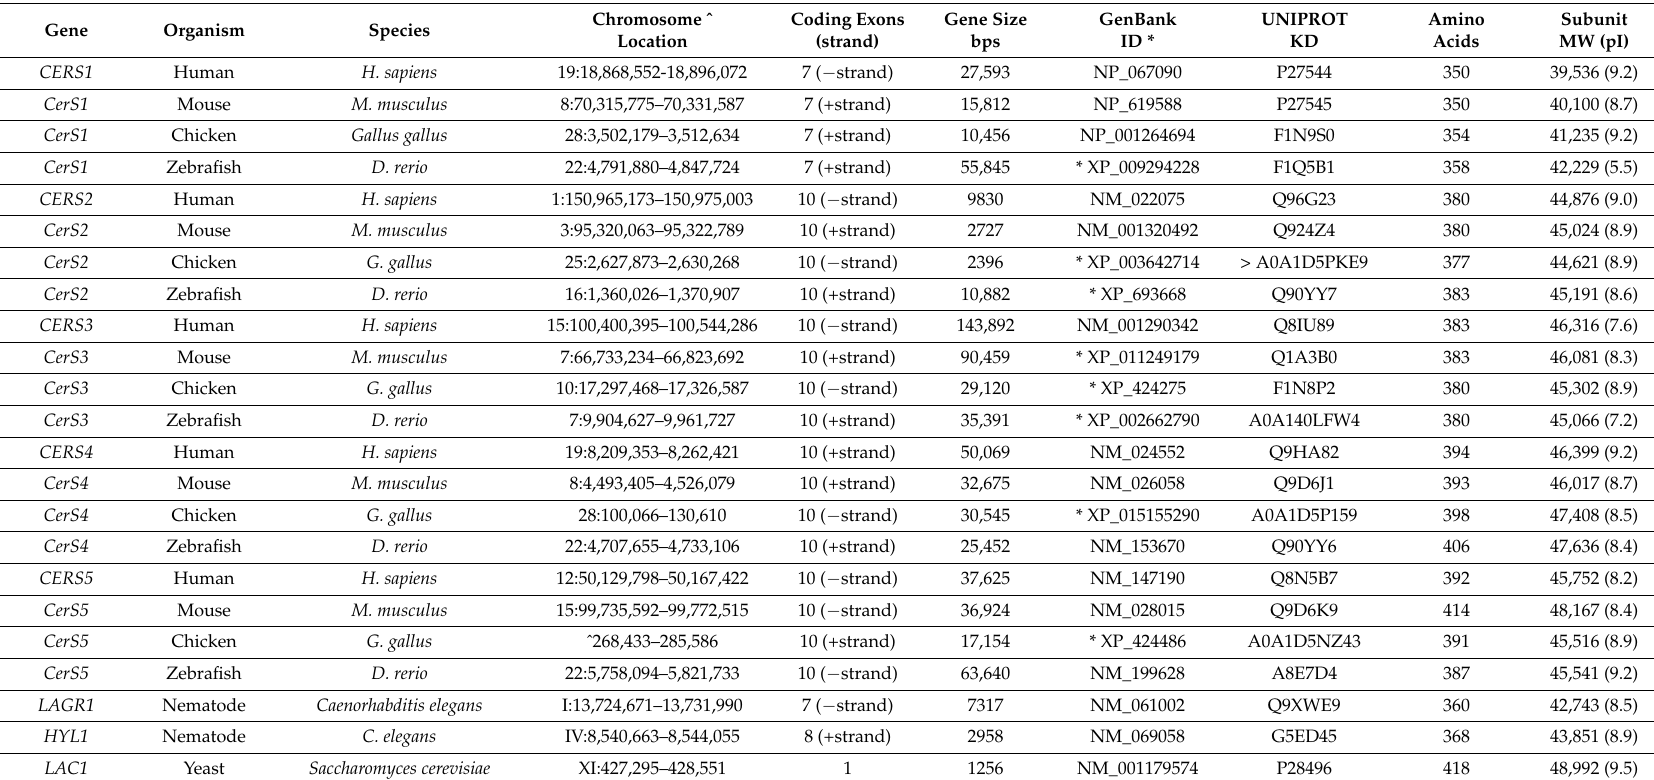
Table 2. Vertebrate, nematode and yeast CerS -like genes and